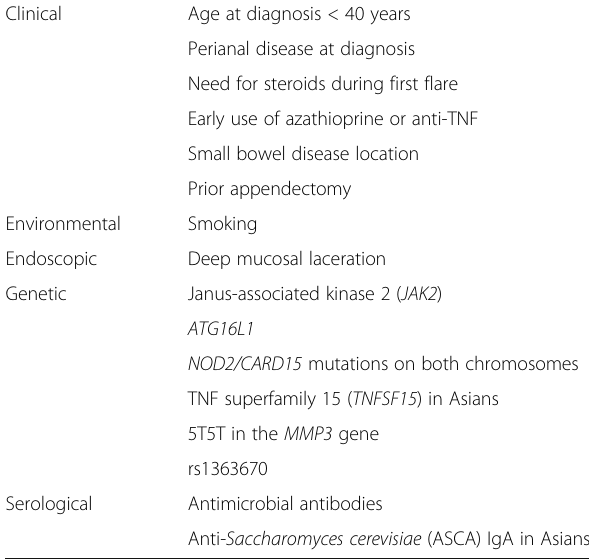
Table 1 Predictors of fibrostenosing Crohn ’ s disease